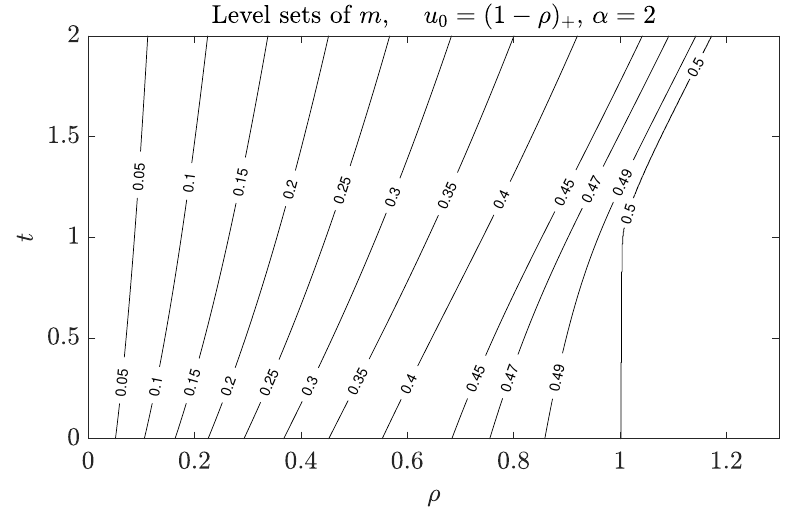
Fig. 9: Level sets of the numerical solution with u 0 = (1 − ρ ) + for α = 2 , and a uniform mesh in space of equispaced grid h ρ = 1 e − 3 . In Figure 6 the reader may find a comparison with the mass subsolution with explicit